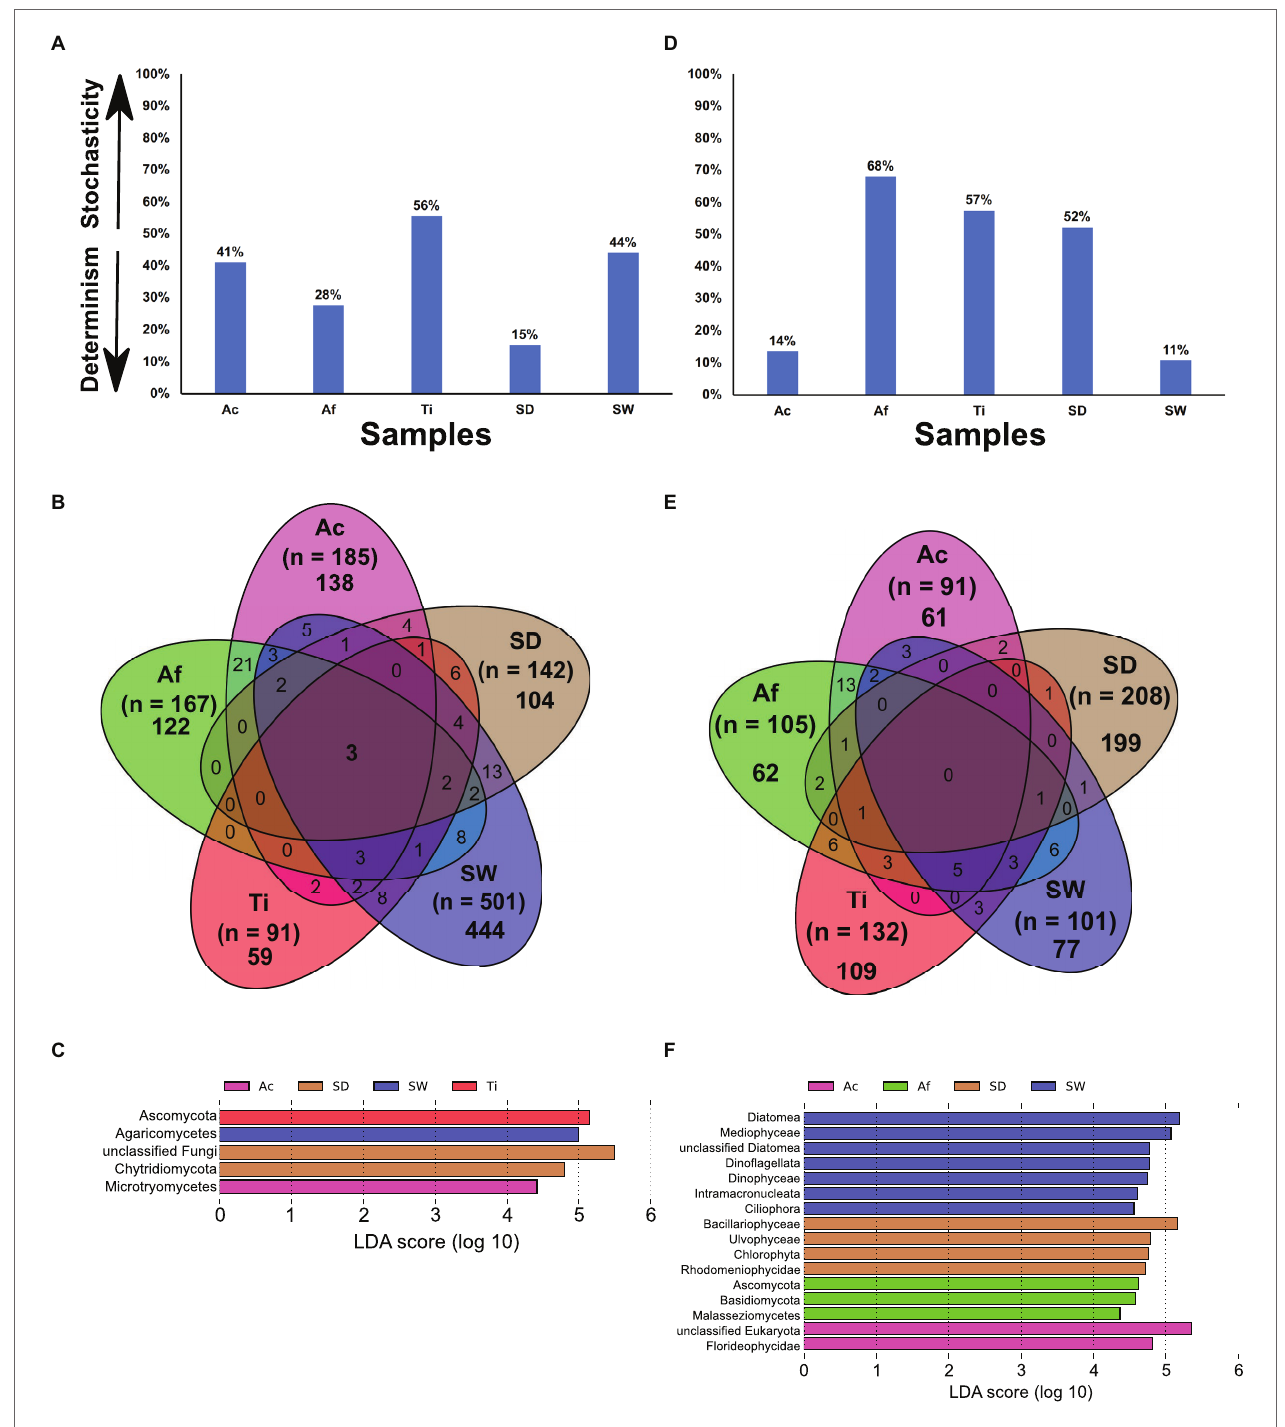
FIGURE 6 | The MST, Venn diagram with all OTUs detected in Ac ( Aplysina caissara , magenta), Af ( Aplysina fulva , green), Ti ( Tedania ignis , red), SW (seawater, blue), and SD (sediment, brown), and taxonomic representation of statistically and biologically consistent differences across Ac, Af, Ti, SW, and SD are presented for fungal (A–C) and unicellular eukaryotic (D–F) datasets,